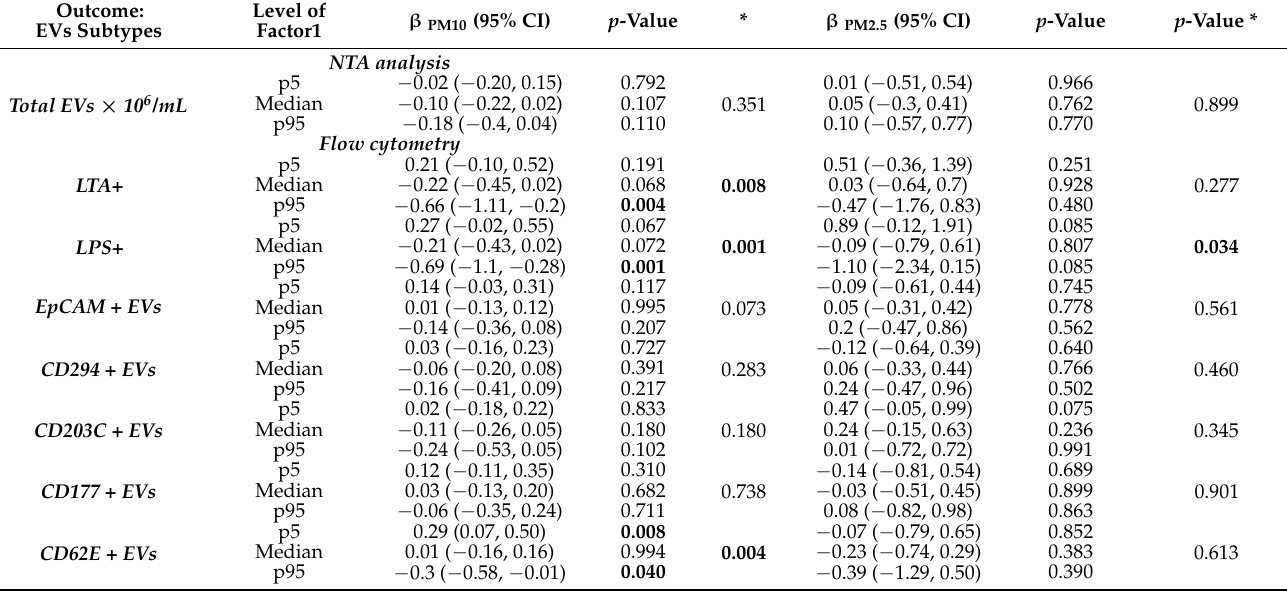
Table 7. Association between PM and EVs subtypes for the selected values of Factor1, which is characterized by the greatest positive loadings on Streptococcus, Actinomyces, Rothia, and